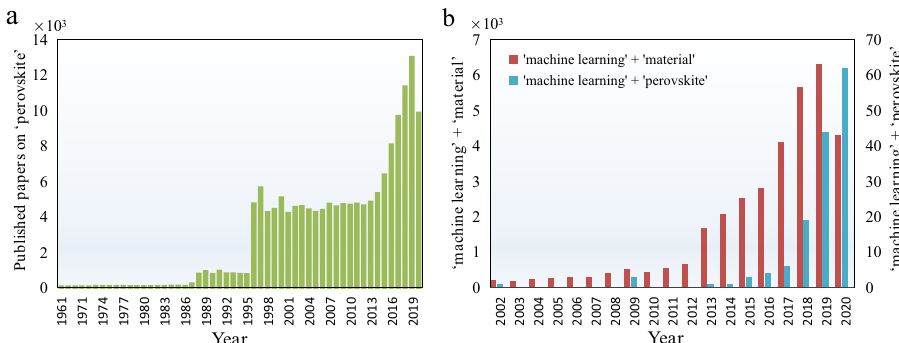
Fig. 1 Number of published papers. a On keyword of ‘ perovskite ’ (from 1961 to December 2020). b On key words of ‘ machine learning and material ’ and ‘ machine learning and perovskite ’ (from 2002 to December 2020).